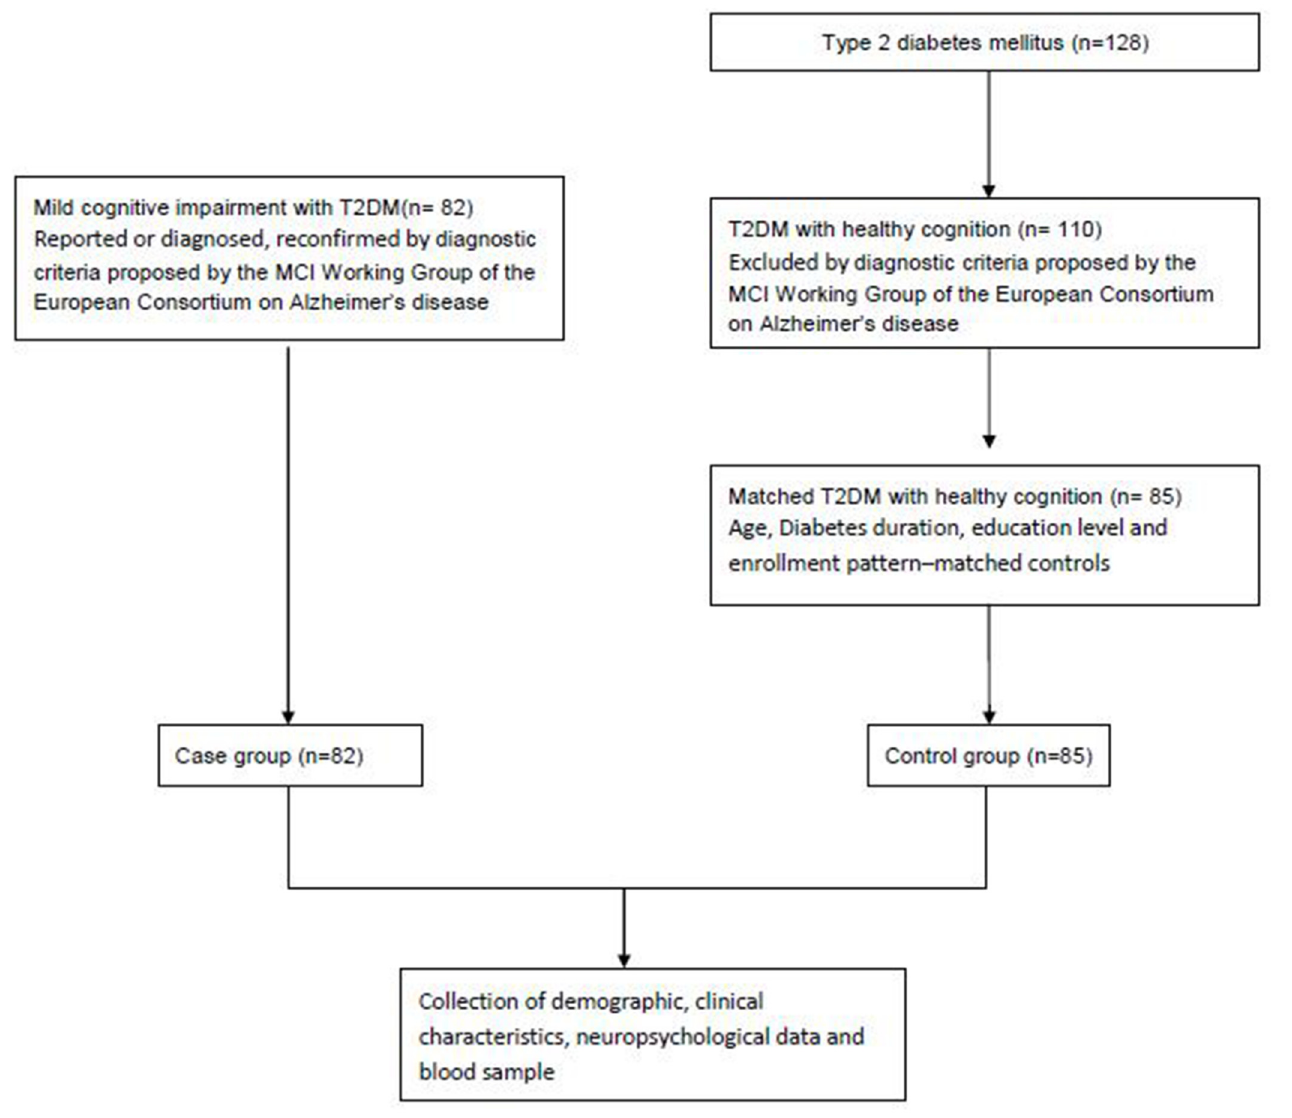
Fig 1. Flow chart of study